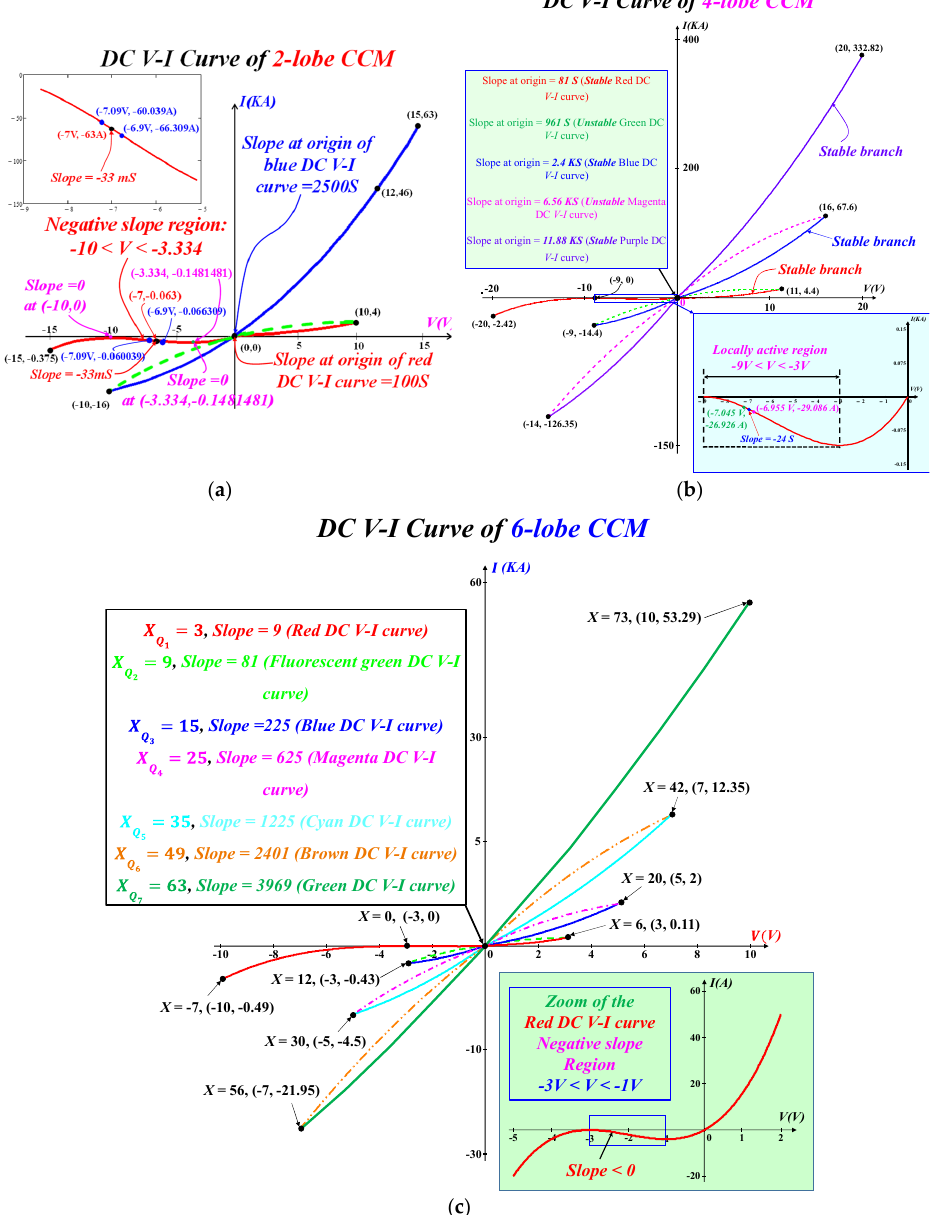
Figure 2. DC V-I curves of ( a ) 2-lobe CCM , (b) 4-lobe CCM , and (c) 6-lobe CCM . The lower right insets of figure ( b ) and ( c ) show the zoomed portion of red DC V-I curves and the upper left insets show the slope and state variable X values at V = 0 V , respectively.